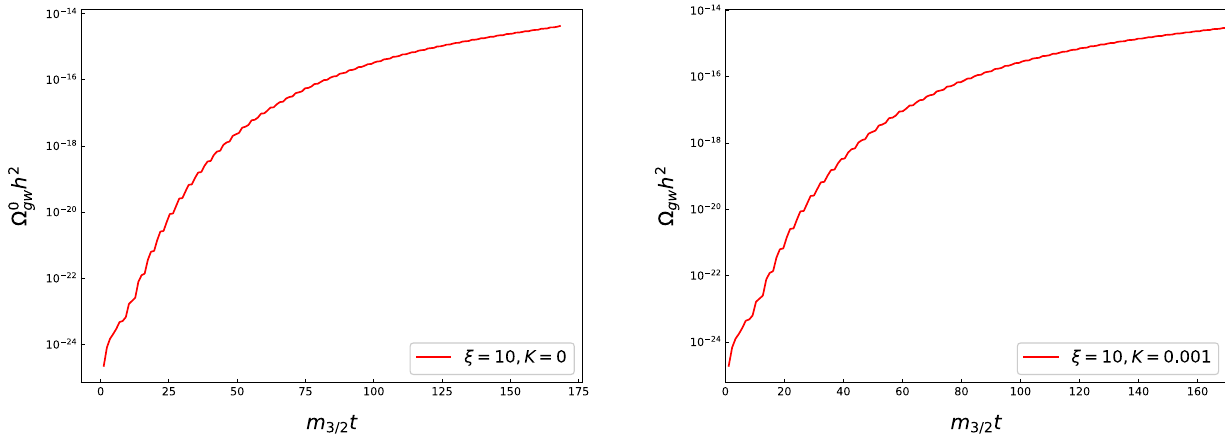
Fig. 2 The panels show the temporal evolution of the present GW density parameter (cid:12) 0 g w h 2 for the two benchmarks points (in Fig. 1) with K = 0 ,ξ = 10 (left panel) and K = 0 . 001 ,ξ = 10 (right panel),